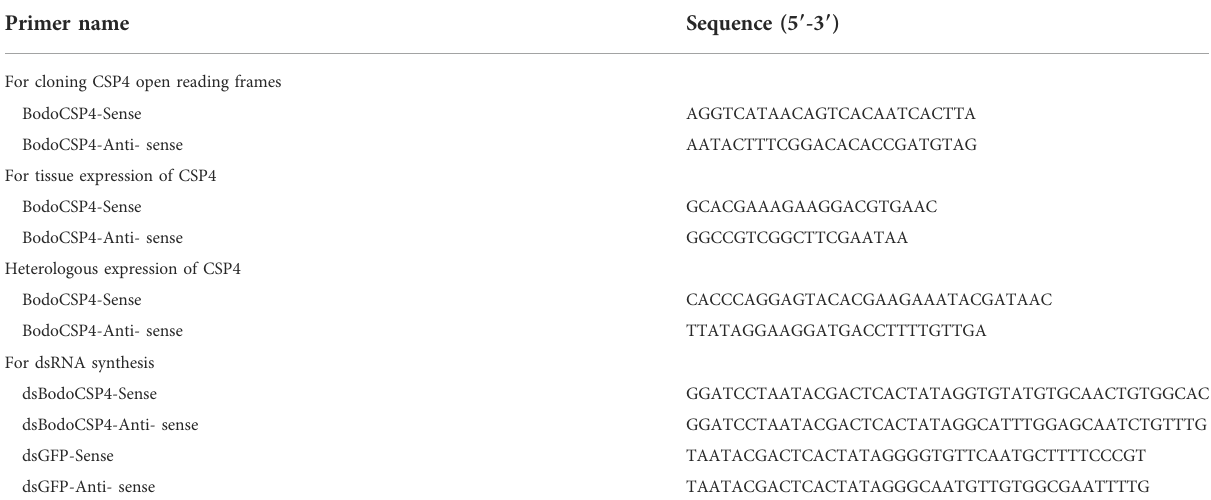
TABLE 1 Primers used in cloning and expression of CSP4 in B.odoriphaga